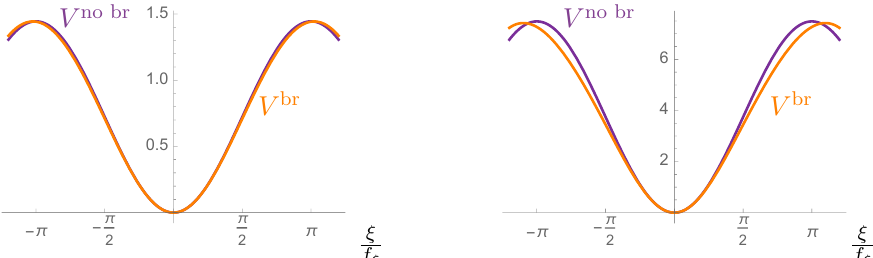
Figure 10 . Back-reacted scalar potential as a function of in(cid:13)aton (cid:24) with parameter choice (cid:22) = 10 (cid:21) = (cid:20) = 10 M = 10 16 GeV (left) and (cid:22) = 10 (cid:21) = (cid:20) = 2 M = 10 16 GeV (right). The purple curve represents the non-back-reacted scalar potential V no br , while the orange curve corresponds to the back-reacted scalar potential V br